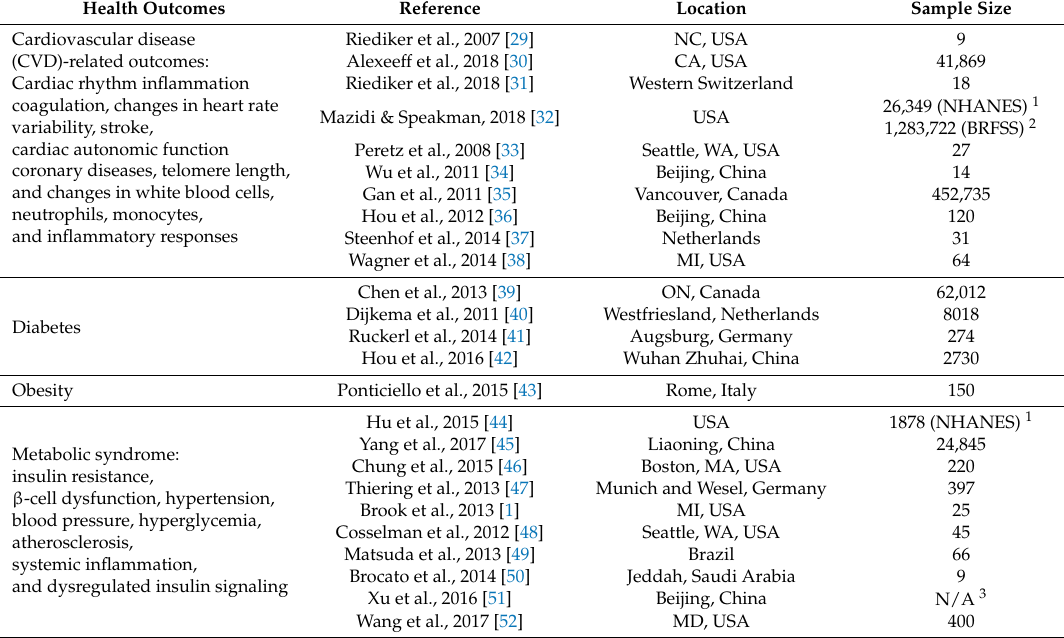
Table 1. Summary of traffic-related PM and cardiometabolic health outcomes from 25 selected epidemiological, controlled human exposure, and toxicological research studies based on the eligibility criteria (more details in Table